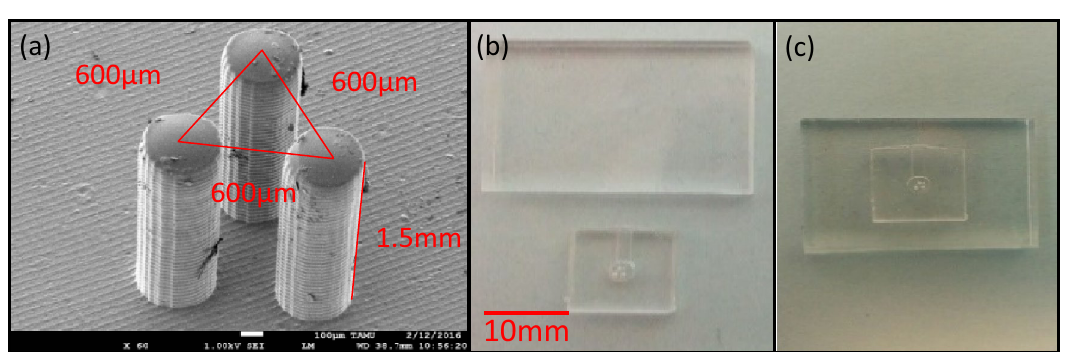
Figure 4. SEM image of three fingers, and assembling and finalizing the microgripper. ( a ) SEM image of fingers. The diameter of each finger is 300 μm and the center-to-center distance between every two fingers is 600 μm. The Triangle in the image shows the center-to-center distances between fingers. The length of each finger is 1.5 mm. ( b ) Microgripper’s elements. ( c ) Finalized